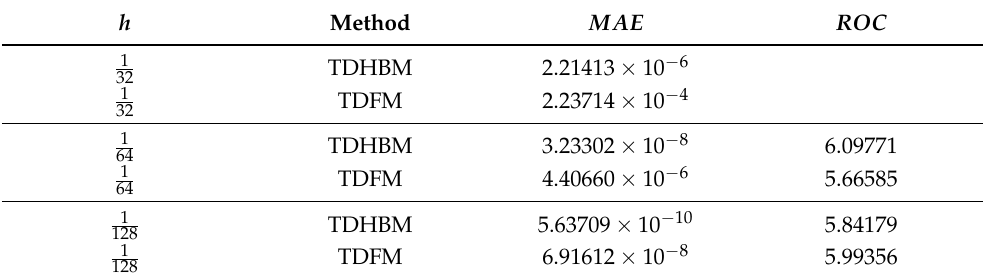
Table 5. Comparison of MAEs and order of convergence for Problem (24).